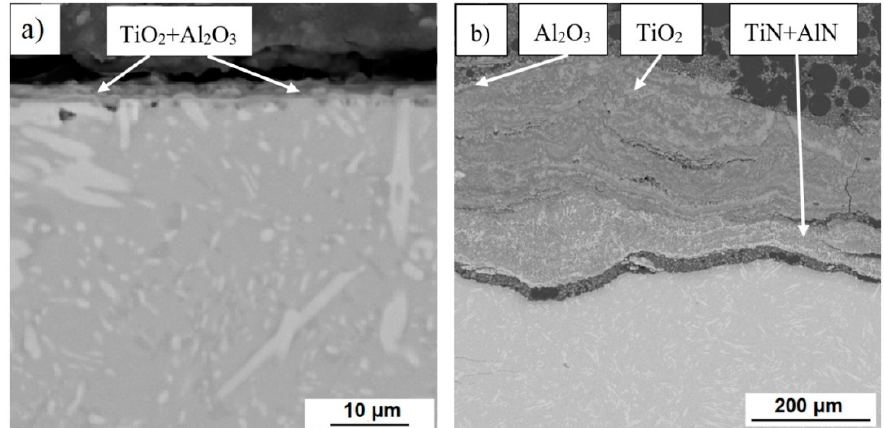
Figure 12. Microstructure (SEM-BSE) of oxide layers of TiAl35Si5 alloy, prepared by centrifugal casting followed by hot isostatic pressing, after cyclic oxidation at ( a ) 800 °C and ( b ) 1000 °C for 400 h.